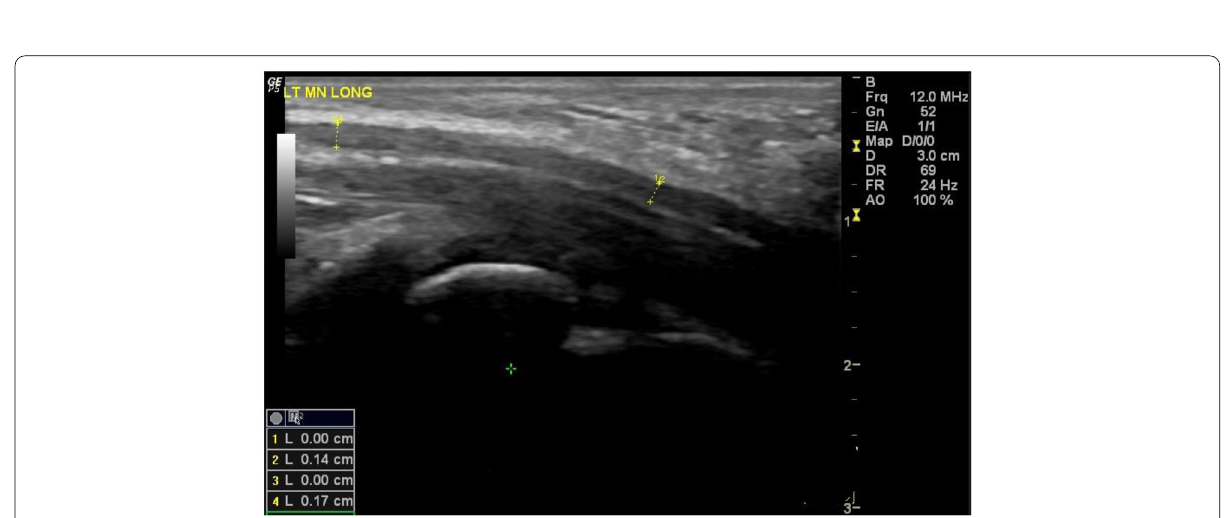
Fig. 8 Longitudinal section of left median nerve showing “ notch sign” (abrupt reduction in the vertical dimension of the median nerve as it enters the carpal